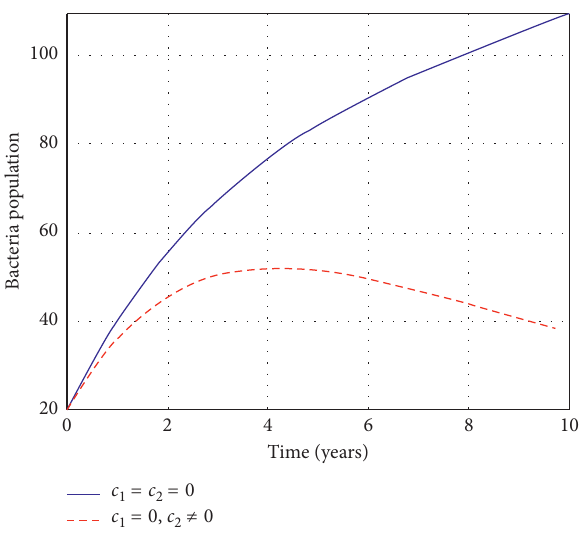
Figure 11: A graph showing the effectiveness of control measure c only in the bacteria population.